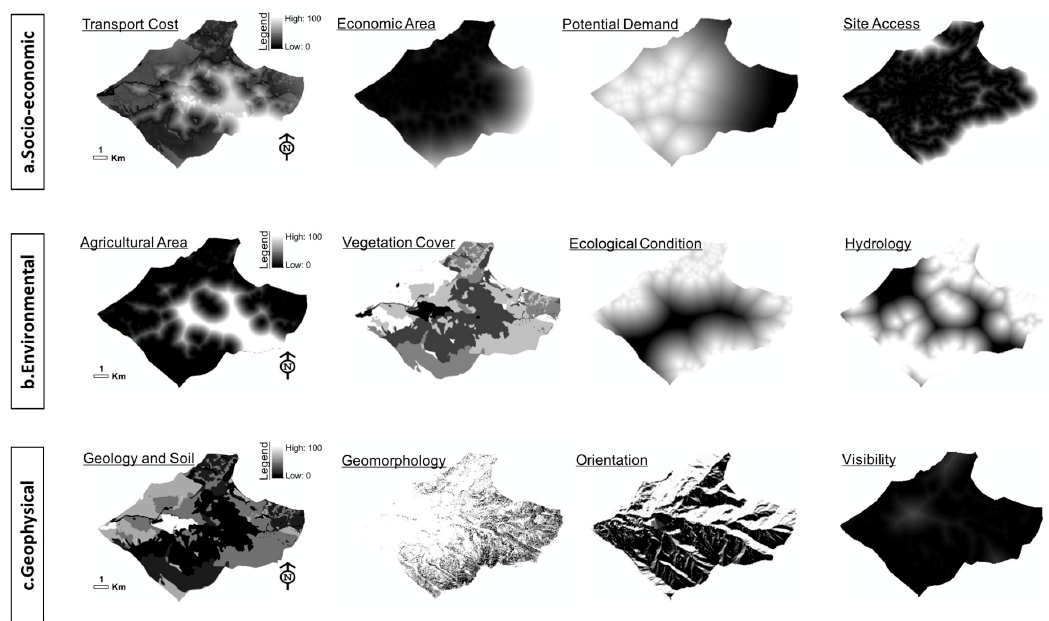
Figure 3. Analyzed maps of each sub-criterion: ( a ) Socio-economic; ( b ) Environmental and ( c ) Geophysical.